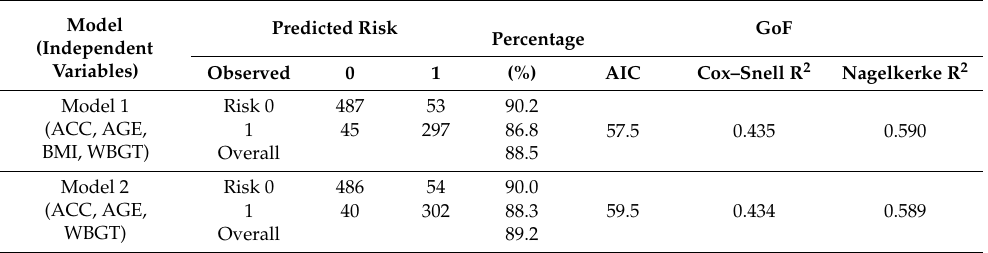
Table 10. Overview of subjects’ physical demand